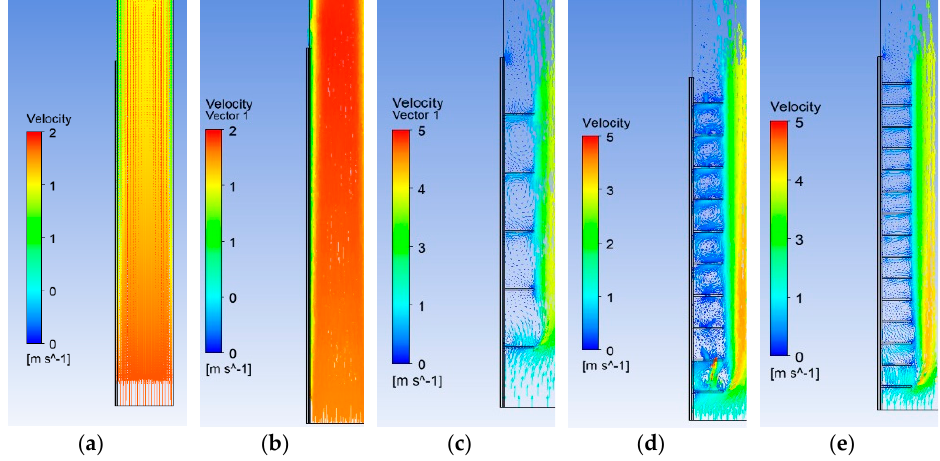
Figure 7. Wind speed vector ( a ) without cooling ( b ) no fins, ( c ) 5 fins, ( d ) 10 fins, and ( e ) 15 fins.